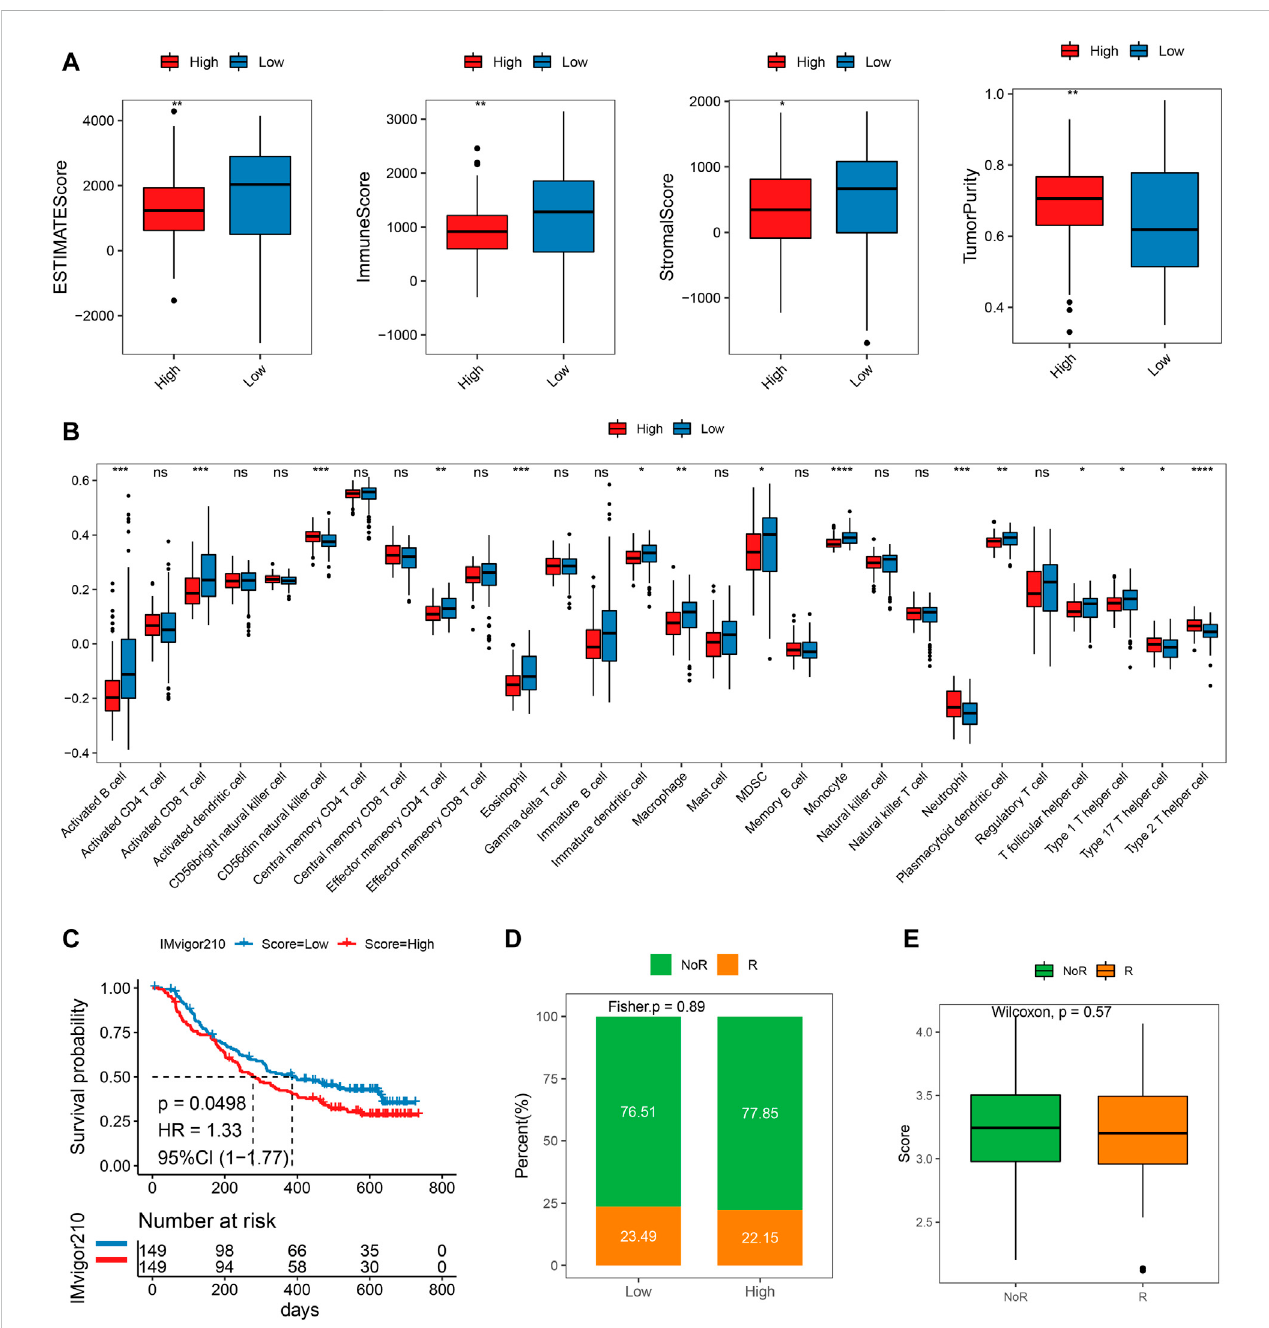
FIGURE 7 Difference of immune in fi ltration and prognosis of immunotherapy between high and low-risk scoring groups. (A) ESTIMATEScore, ImmuneScore, StromalScore, TumorPurity of high and low score groups; (B) Immune in fi ltration score of high-risk groups; (C) KM curve of the high or low-risk groups; (D) Objective response rate in high- and low-risk groups; (E) Risk score distribution in different clinical response